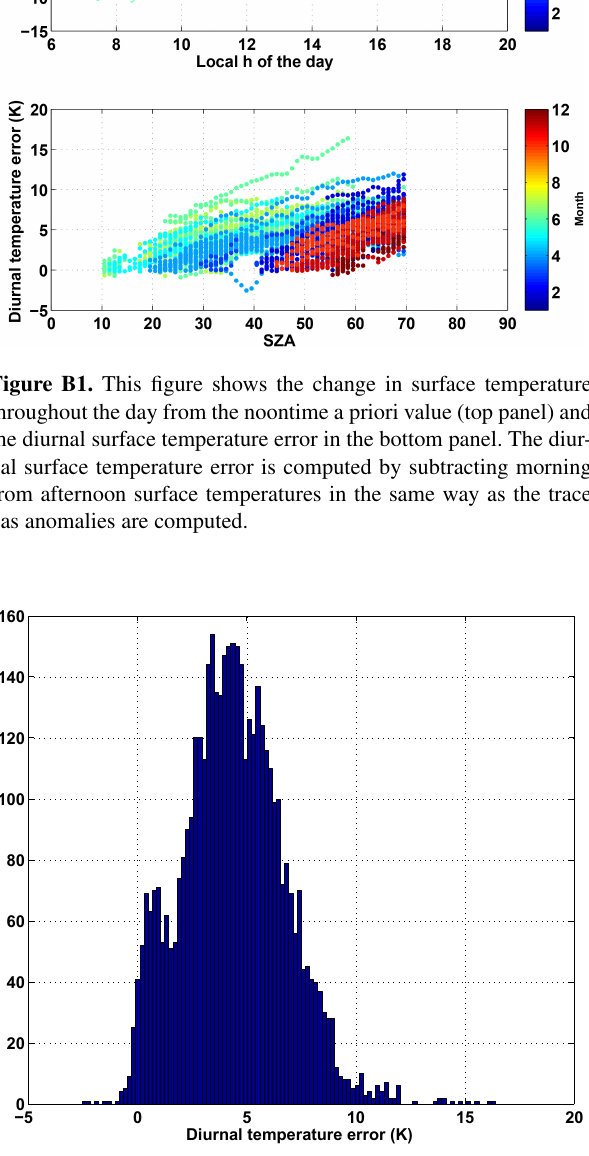
Figure B2. This figure shows a histogram of the surface temperature anomalies shown in the bottom panel of Fig.